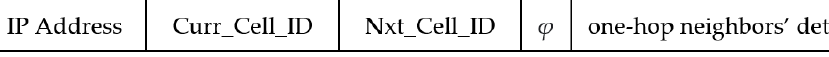
Figure 7. Message format for one ‐ hop neighbor details in the hello message.